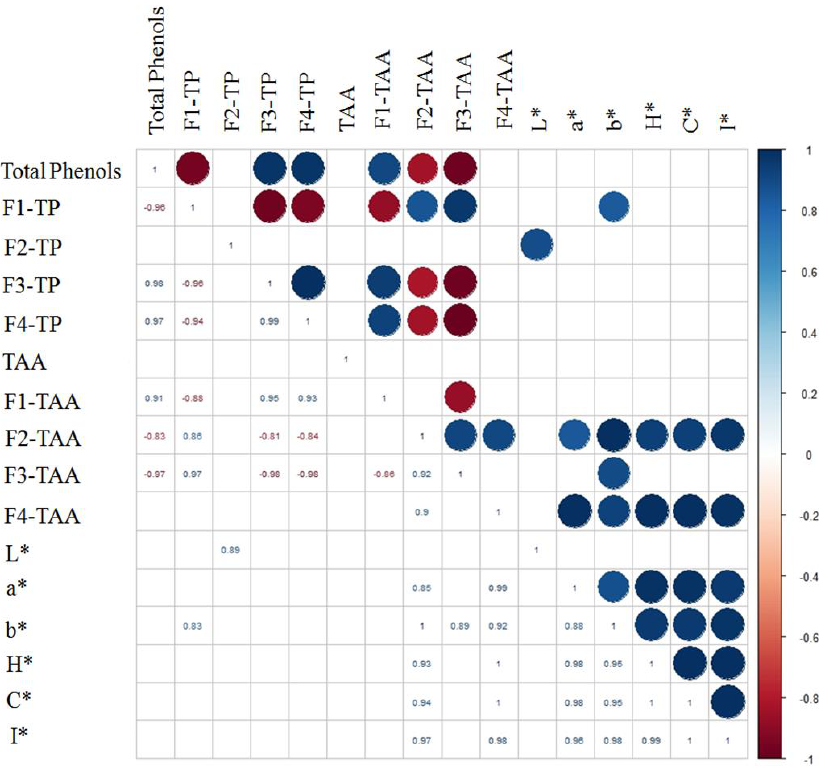
Figure 1. Correlations between total phenols, total antioxidant activity (TAA), their fractions (F1, F2, F3 and F4) and color parameters. Blue circles represent significant positive correlations and red circles represent significant negative correlations.